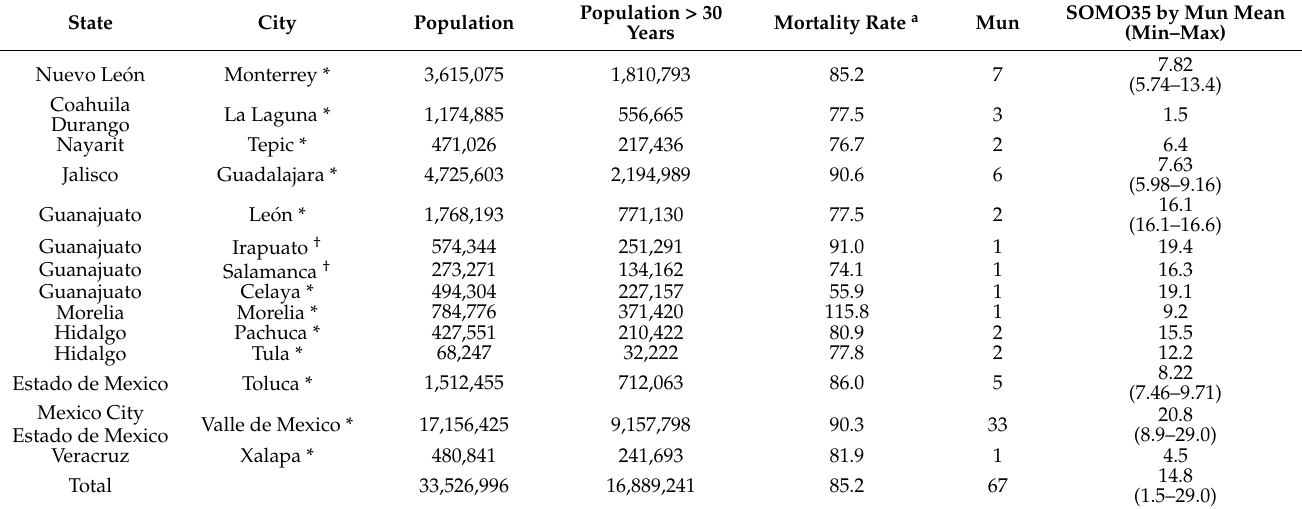
Table 1. Number of municipalities and population in the cities included in the study, 2015.